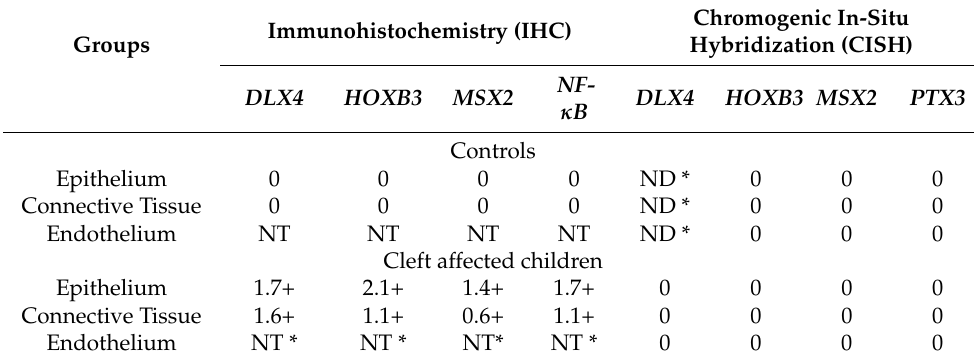
Figure 1. Expression of DLX4 gene visualized using IHC and CISH methods in controls and cleft patients. Protein expression of the DLX4 gene was visualized using immunohistochemistry (IHC) in ( A ) controls and ( B ) cleft affected children. ( A ) No positively stained (0) structures are visible in tissue obtained from controls; ( B ) Moderate number (++) of weakly stained epitheliocytes and distinctly stained connective tissue cells are seen in the cleft tissue obtained from a five-month-old girl. Original magnification, 200×. Gene amplification levels of DLX4 gene was visualized using chromogenic in-situ hybridization (CISH) in ( C ) controls and ( D ) cleft affected children. ( C ) No gene expression and amplification (0) are seen in the tissue obtained from controls; ( D ) No gene amplification (0) is seen; however, gene expression is seen by brown dots in the nucleus of the epithelium and endothelium cells in the cleft tissue obtained from an eight-month-old boy. Original magnification, 1000×. Red star indicates epithelium; green star indicates connective tissue, while purple star indicates endothelial cells. Table 1. Average semi-quantitative score of the results obtained from IHC and CISH.